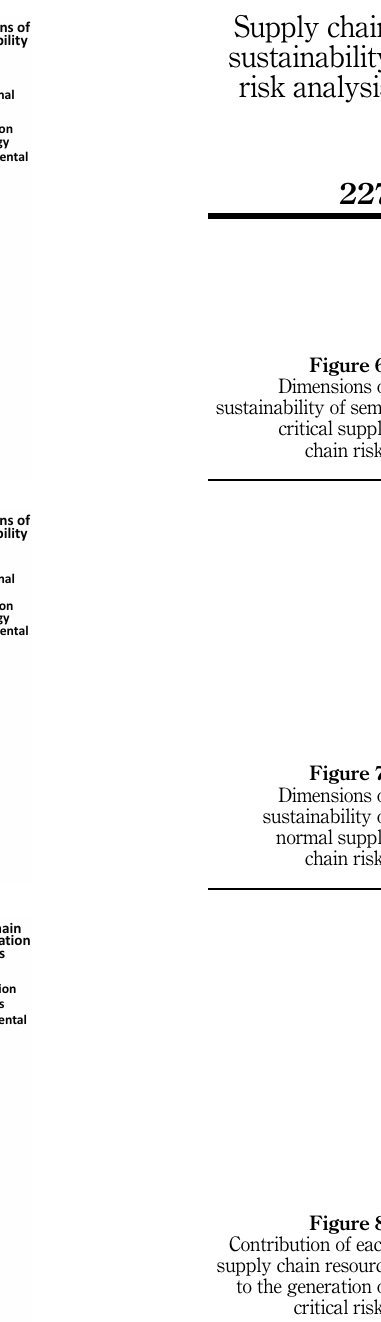
Figure 7. Dimensions of